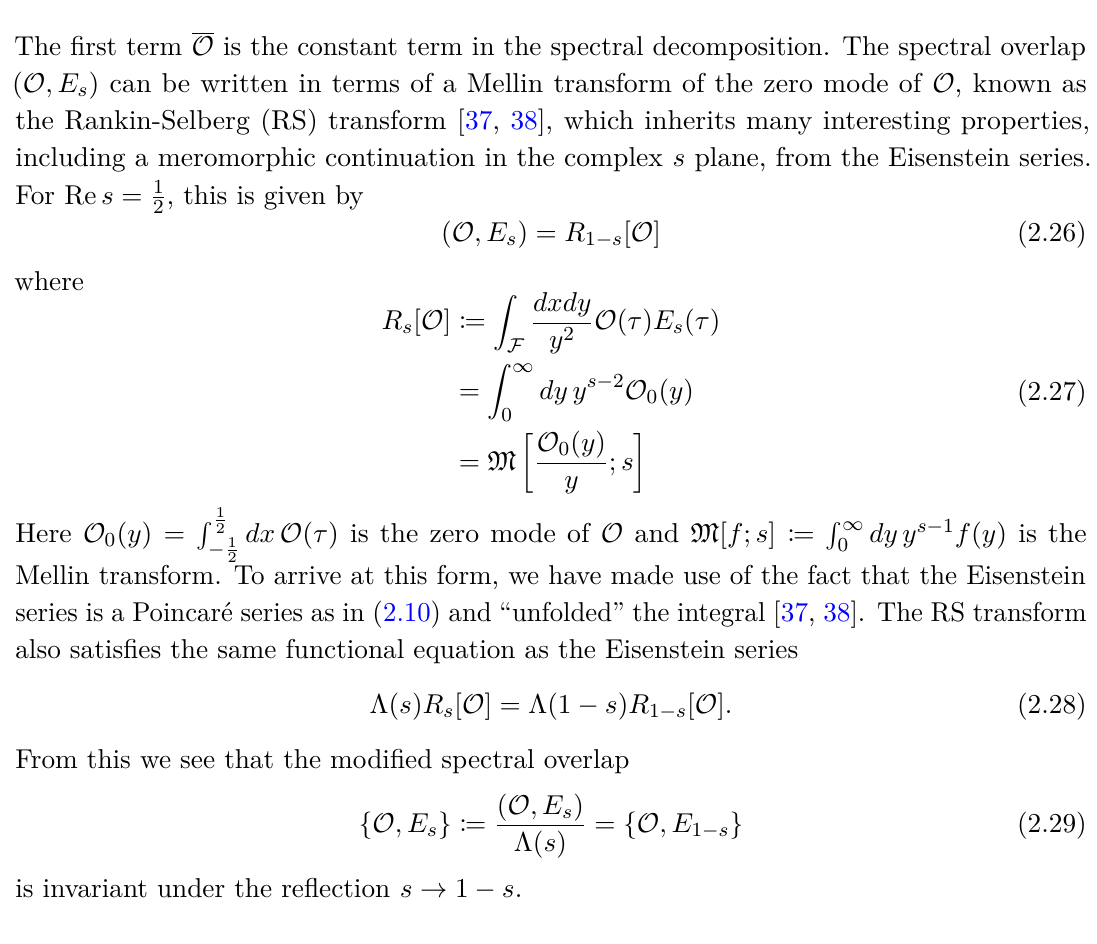
Figure 2. A plot of the zero mode of the square of the Eisenstein series E 1 factor of 1 / 2 ) and of the first three even Maass cusp forms, defined as ( φ 2 0 < y ≤ 1 . The data for the cusp forms was obtained using the first 400 Fourier coefficients, known numerically to over 100 digits, available at